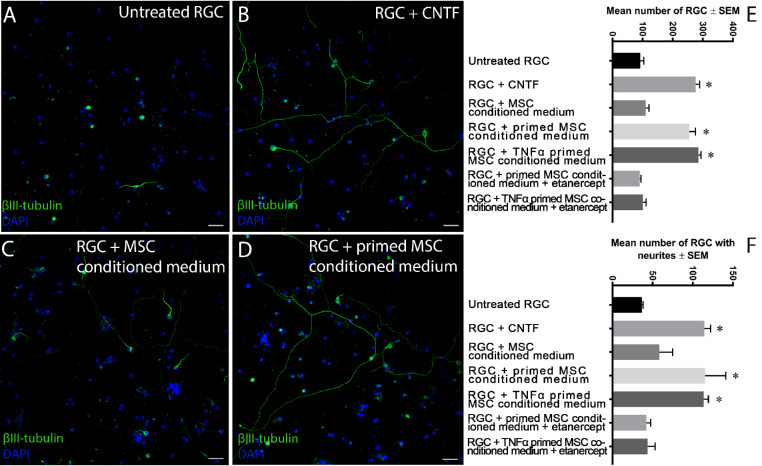
MSC conditioned medium treatment of heterogenous retinal cultures. Heterogenous adult rat retinal cultures were left for three days either untreated (negative control; A), treated with CNTF (positive control; B), treated with MSC conditioned medium (C), treated with primed MSC conditioned medium without (D) or with etanercept (TNFα blocker) added during priming, or treated with TNFα primed MSC conditioned medium without or with etanercept added during priming (scale bar: 50 µm). The number of RGCs (E), denoted by their asymmetrical βIII-tubulin staining, and the number of RGCs with neurites (F) were quantified (n = 3). Asterisks indicate a significant increase in RGC neuroprotection/neuritogenesis in comparison to untreated control/unprimed MSC conditioned medium (P < 0.05) and includes CNTF treatment and primed MSC (via retinal medium or TNFα) conditioned medium treatment.